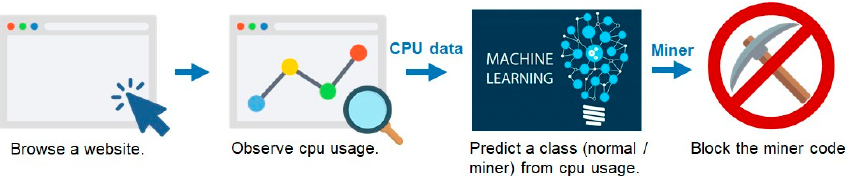
Figure 7. Execution flow of MinerGuard.